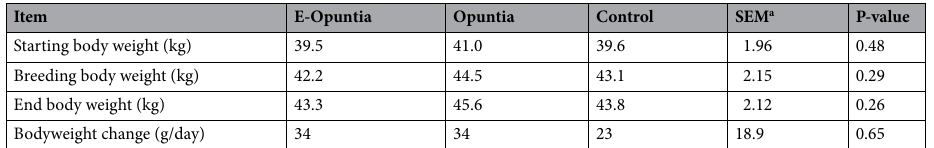
Table 1. Ewe body weight at the start of the experiment, at the start of breeding, and at the end of breeding period, and bodyweight change during the breeding period in mature Rambouillet ewes. The animals were offered only alfalfa (Control), protein-enriched opuntia (E-Opuntia) or Opuntia during the breeding period. a Standard error of the mean from the mixed model